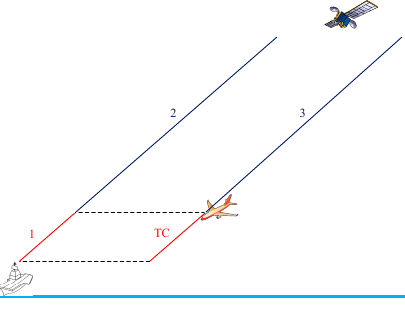
Figure 1. Tropospheric delay paths.